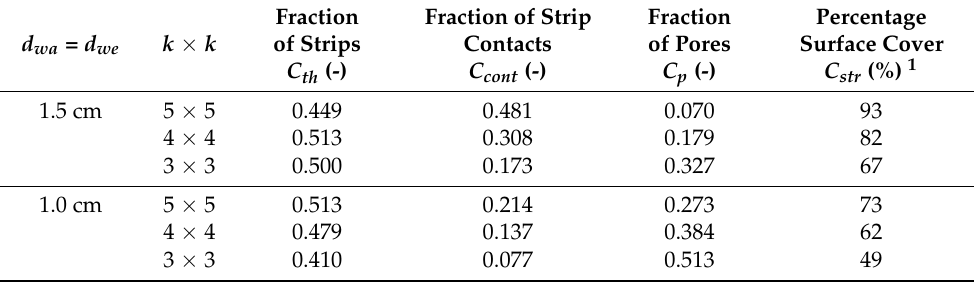
Table 4. The fraction share of components in the whole woven